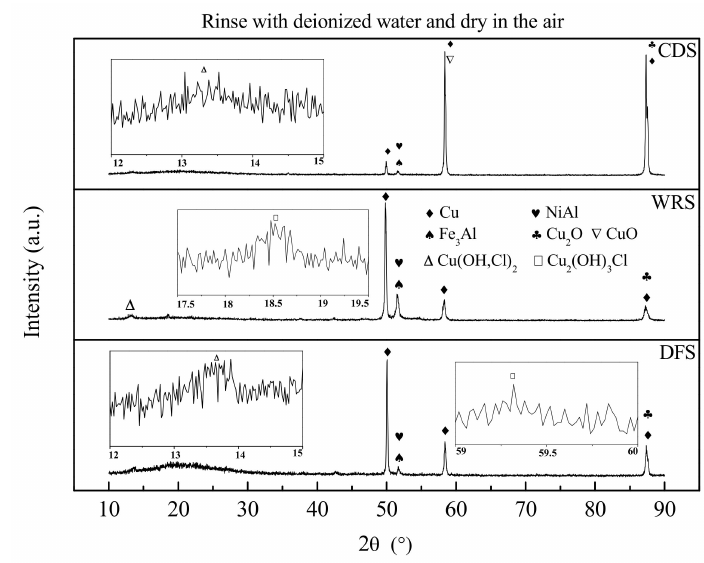
Figure 10. The XRD patterns of DFS, WRS and CDS immersed in 3.5% NaCl solution for 432